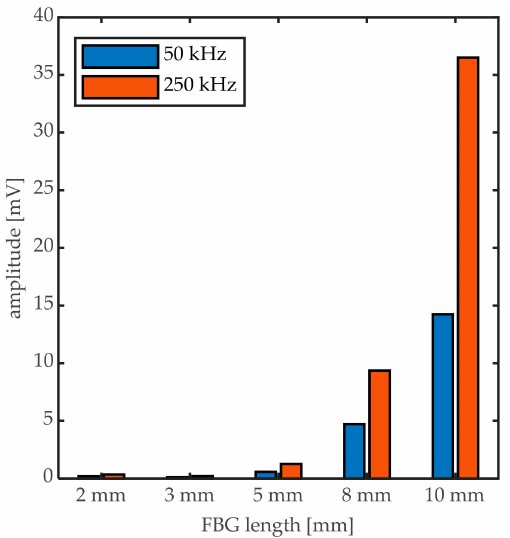
Figure 14. Absolute maximum amplitude of the UGWs measured by di ff erent FBG length.